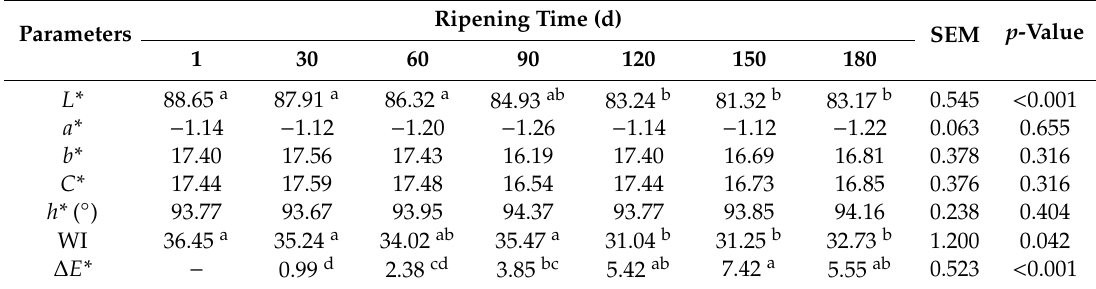
Table 3. Changes in CIELAB color and whiteness index of Mexican Manchego-style cheese made from hair sheep milk at di ff erent points of ripening.